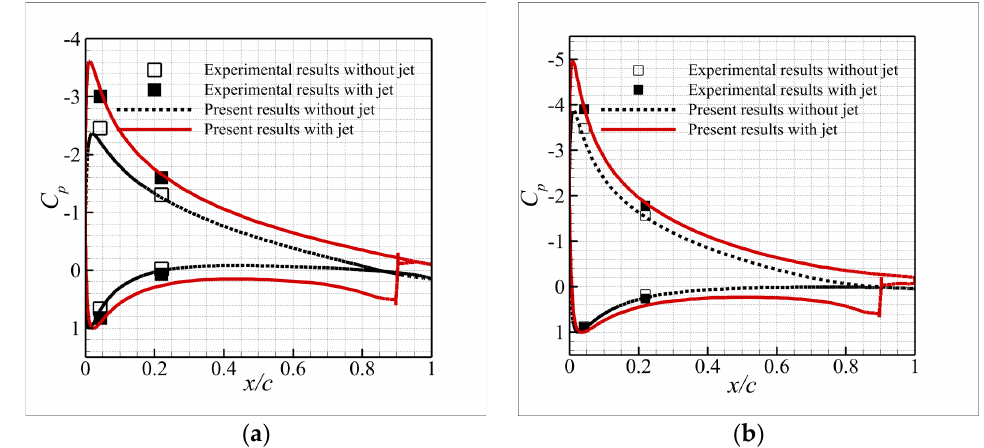
Figure 5. Comparison of the pressure coefficient distributions by the experimental and present results. ( a ) α = 8 ◦ ; ( b ) α = 12 ◦ .